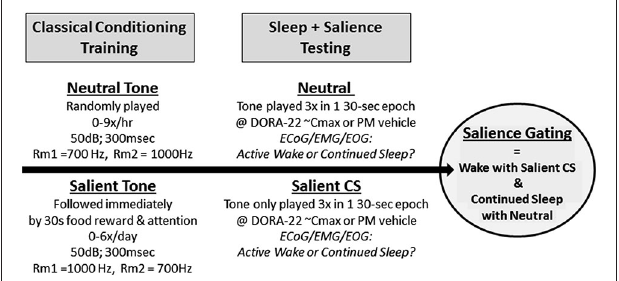
FIGURE 1 | Salience-gated arousability paradigm in dogs . Dogs ( n = 8) were classically conditioned to anticipate nothing (Neutral) or food reward with positive attention (Salient) following a 300 ms acoustical stimulus. During salience testing, only the Neutral or Salient Conditioned Stimulus (CS) tone were presented to sleeping dogs (2 tests/dog/condition); no room entry or reward was given. Telemeterized polysomnography (PSG) was used to quantify Active Wake or continued sleep in response to the differently salienced